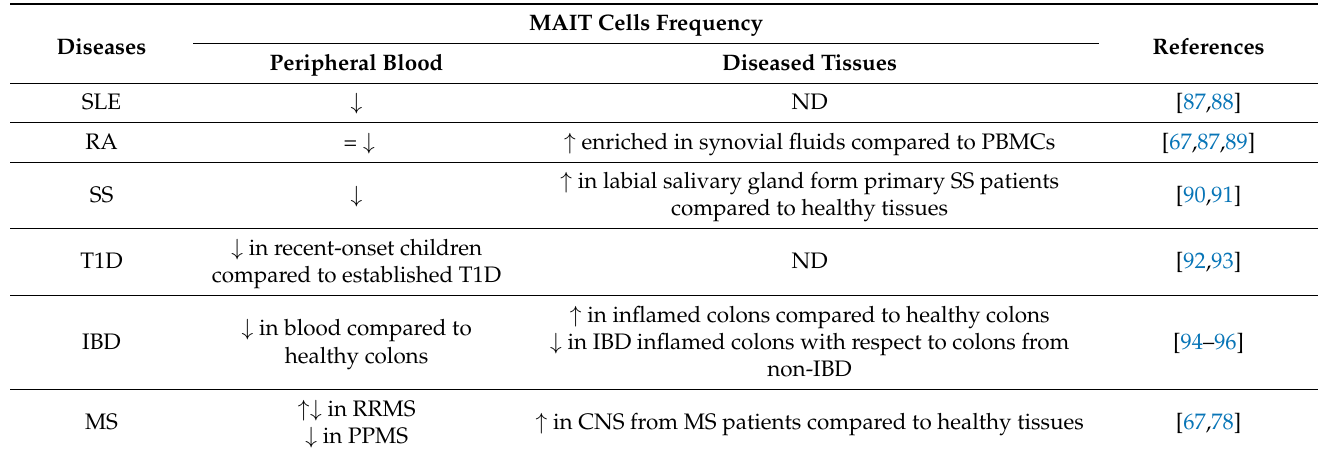
Table 1. MAIT cell frequency in autoimmune diseases in different